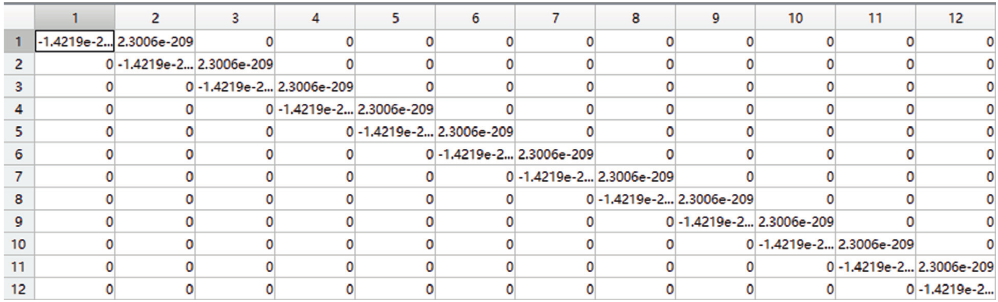
Figure 1: The result of Lemma 5.